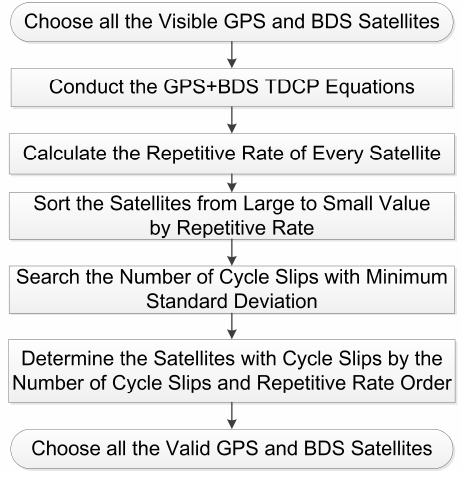
Figure 3. Cycle Slips Detection Flow of ILAM.